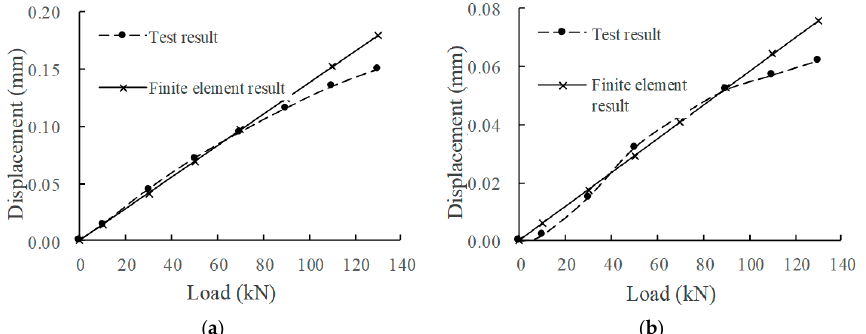
Figure 9. Displacement of track slab relative to base: ( a ) 0 million times of train load; ( b ) 30 million times of train load.